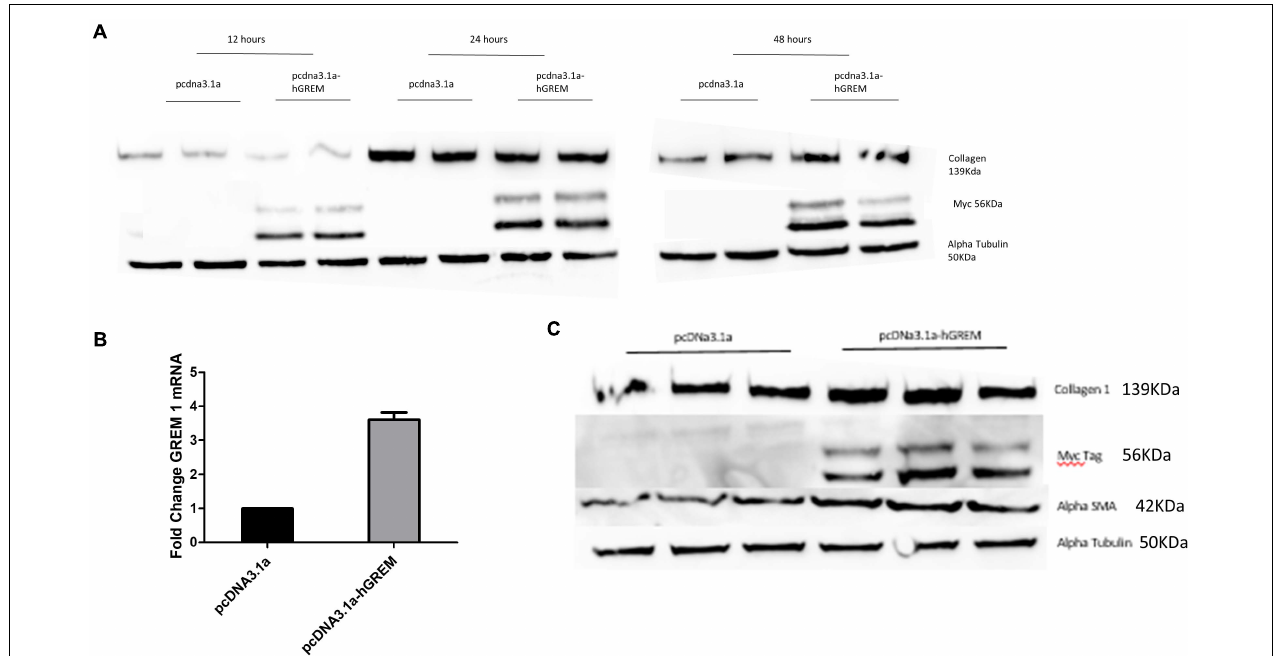
FIGURE 1 | Gremlin-1 increases myofibroblast differentiation. (A) Normal human dermal fibroblasts were transfected with pcDNA3.1a construct with or without the human Gremlin-1 gene. Western blots were conducted at 12, 24, and 48 ( n = 3) h to assess its affects on the key ECM molecule collagen 1 ( n = 3). (B) qPCR was performed at 48 h to assess the transcription of Gremlin-1. Data is normalized to 18s and shown as fold change compared to empty vector plasmid ( n = 3). (C) Gremlin-1 increases myofibroblast marker alpha smooth muscle actin. Normal human dermal fibroblasts were transfected with the plasmid construct pcDNA3.1a with or without the insert for human Gremlin-1 as detailed in the methods. Forty-eight hours post-transfection cells were lysed and a western blot performed with specific antibodies. Alpha Tubulin is the loading control ( n =